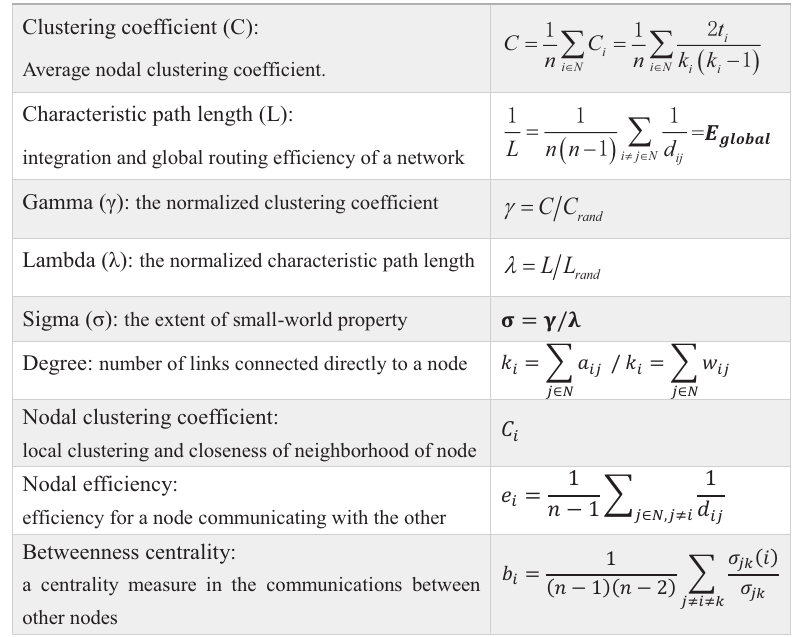
Figure A1. Different measuring parameters of the global and local network properties. Where t i is the number of triangles around node i , d ij is the shortest path length between node i and node j , C rand and L rand refer to the average clustering coefficient and characteristic path length values obtained from 100 random networks with the same number of nodes, as well as edges and the same degree of distribution as the original network, σ jk is the number of shortest paths between j and k and σ jk ( i ) is the number of shortest paths between j and k that pass through i